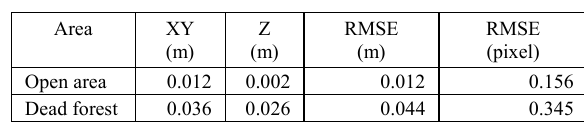
Table 2. Summary of accuracy of snow depth generated UAV